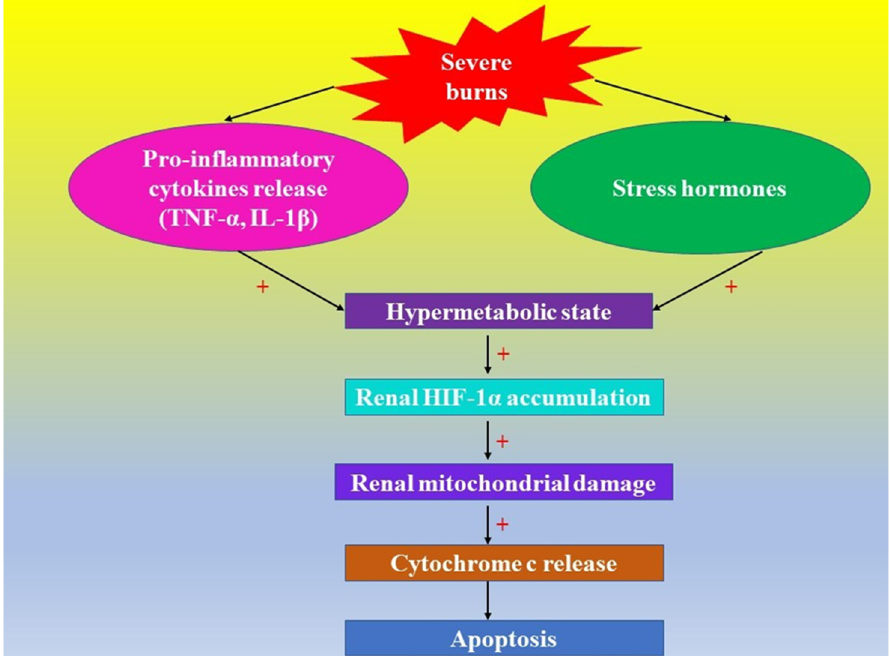
Figure 2. Severe burns and the effects of renal HIF-1 α accumulation induced by a hypermetabolic